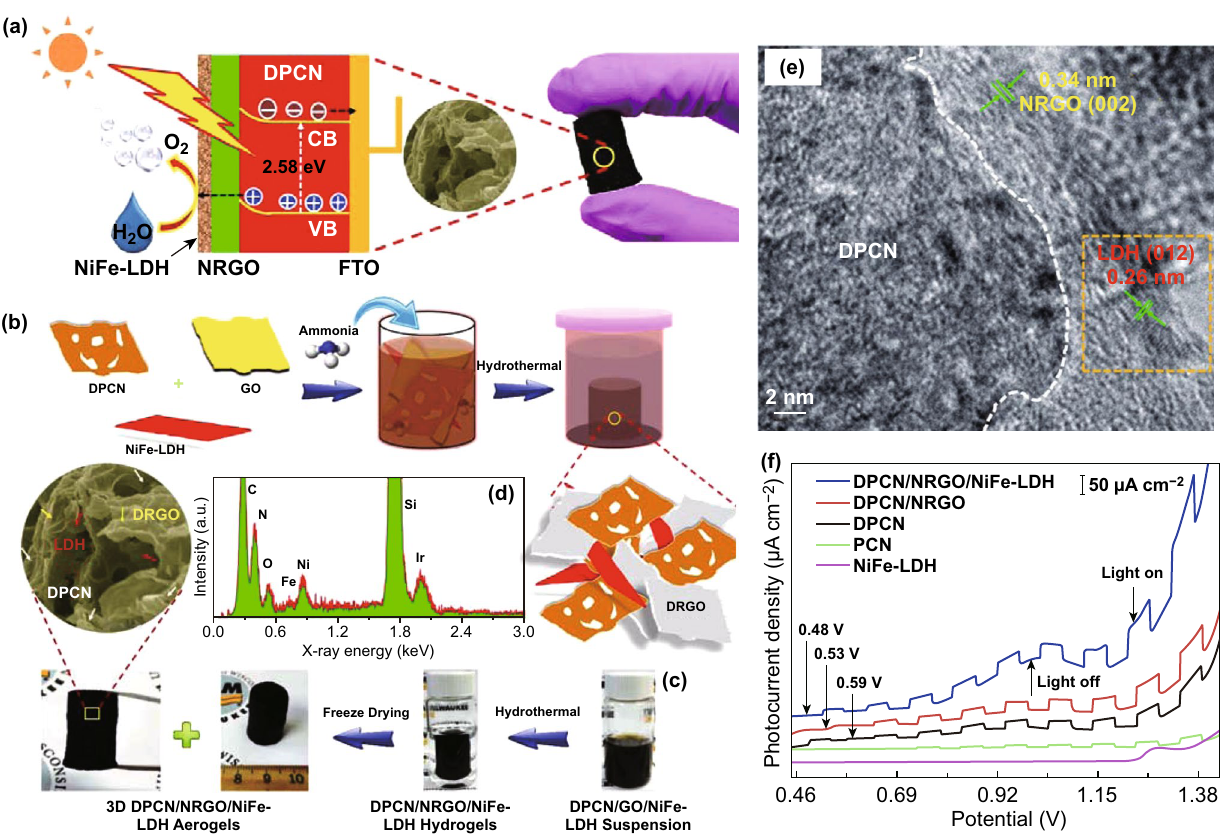
Fig. 8 a Illustration of PEC mechanism over synthesized 2D photoanode, b schematic fabrication process of DPCN/NRGO/NiFe-LDH, c pic- tures of the obtained aerogel samples, d EDX spectrum, and e HRTEM image of DPCN/NRGO/NiFe-LDHs, f photocurrent density vs. applied potential for PCN, DPCN, NiFe-LDH, DPCN/NRGO, DPCN/NRGO/NiFe-LDH under chopped AM 1.5G irradiation. Reproduced with permis- sion from Ref. [150]. Copyright 2016 American Chemical